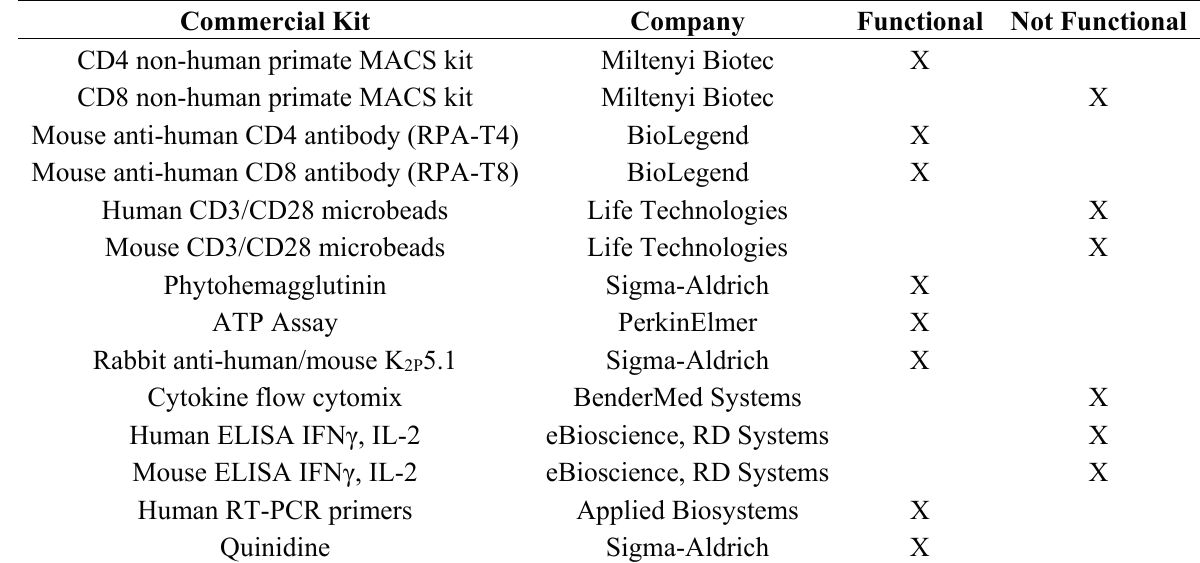
Table 1. Evaluation of commercial kits for marmoset